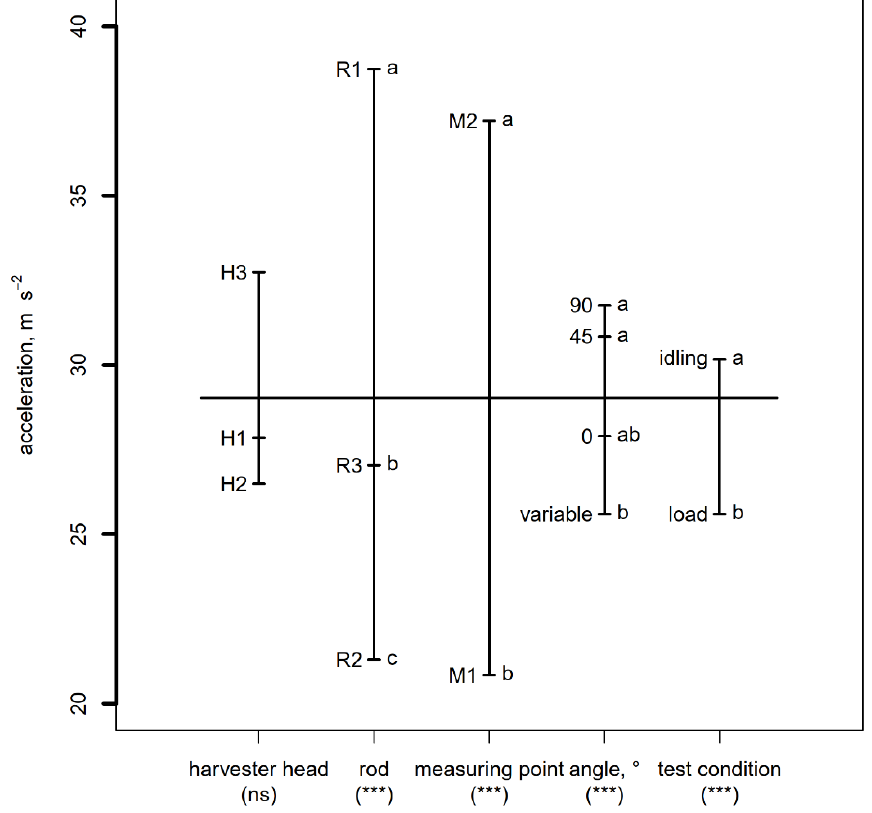
Figure 4. Mean acceleration total values with harvester heads H1–H3 according to the main fac- tors (mean separation by Kruskal–Wallis test at p = 0.05 level; (ns): differences not significant; (***): differences significant at p = 0.001 level).